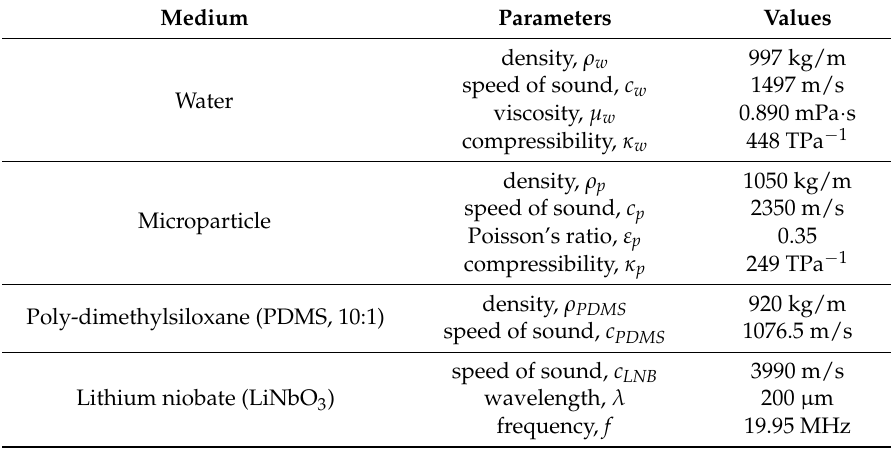
Table 1. Material properties used in the simulation at the temperature of 27 ◦